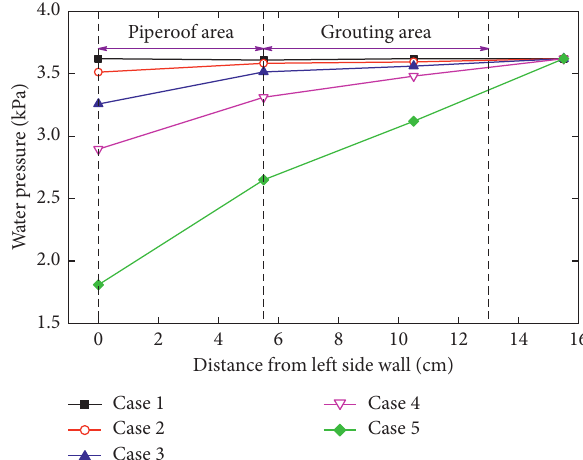
Figure 21: Variation curve of the water pressure outside the tunnel side wall with distance from the tunnel side wall.